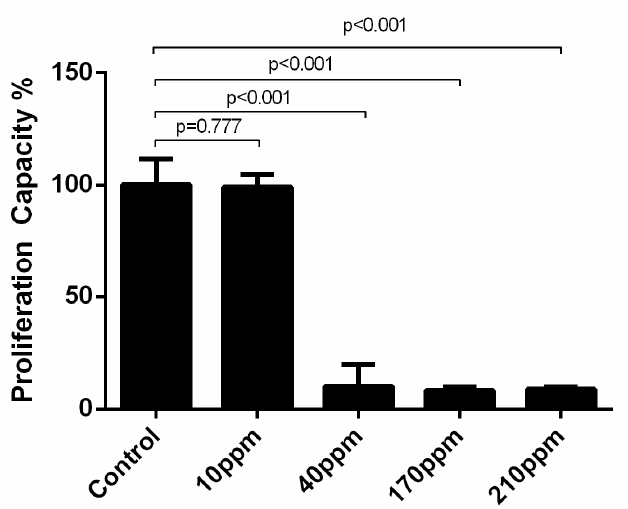
Figure 8. Effect of AgNPs at concentrations of 10–210 ppm, on LNCaP cell proliferation assessed by BrdU incorporation assay after 24 h. Results are expressed as percentage of control (untreated cells) considered as 100%, as mean ± SEM.